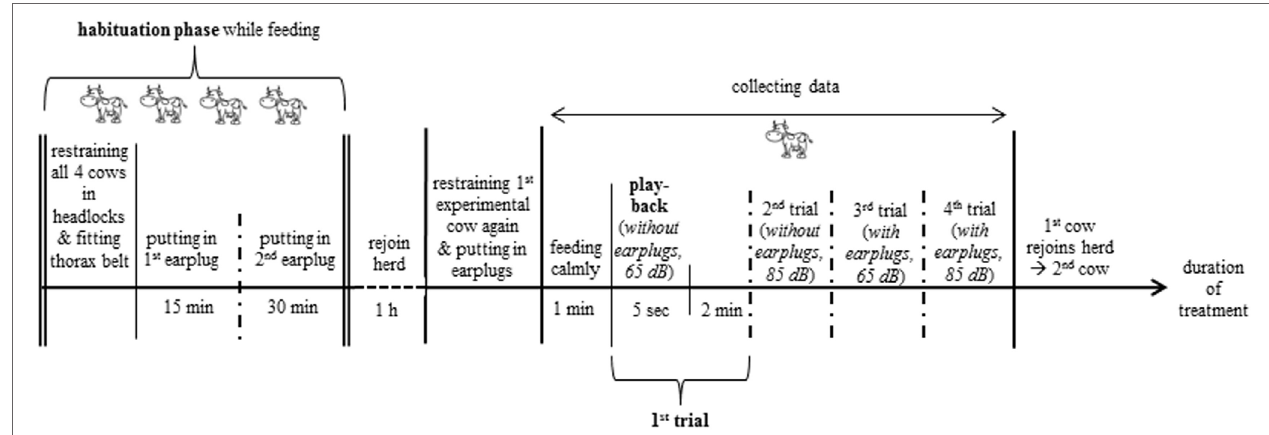
FigUre 3 | Experimental procedure. The two playbacks (65 and 85 dB) with earplugs were tested in consecutive trials; the order of amplitude within a phase (without or with earplugs) and between phases was chosen randomly for each